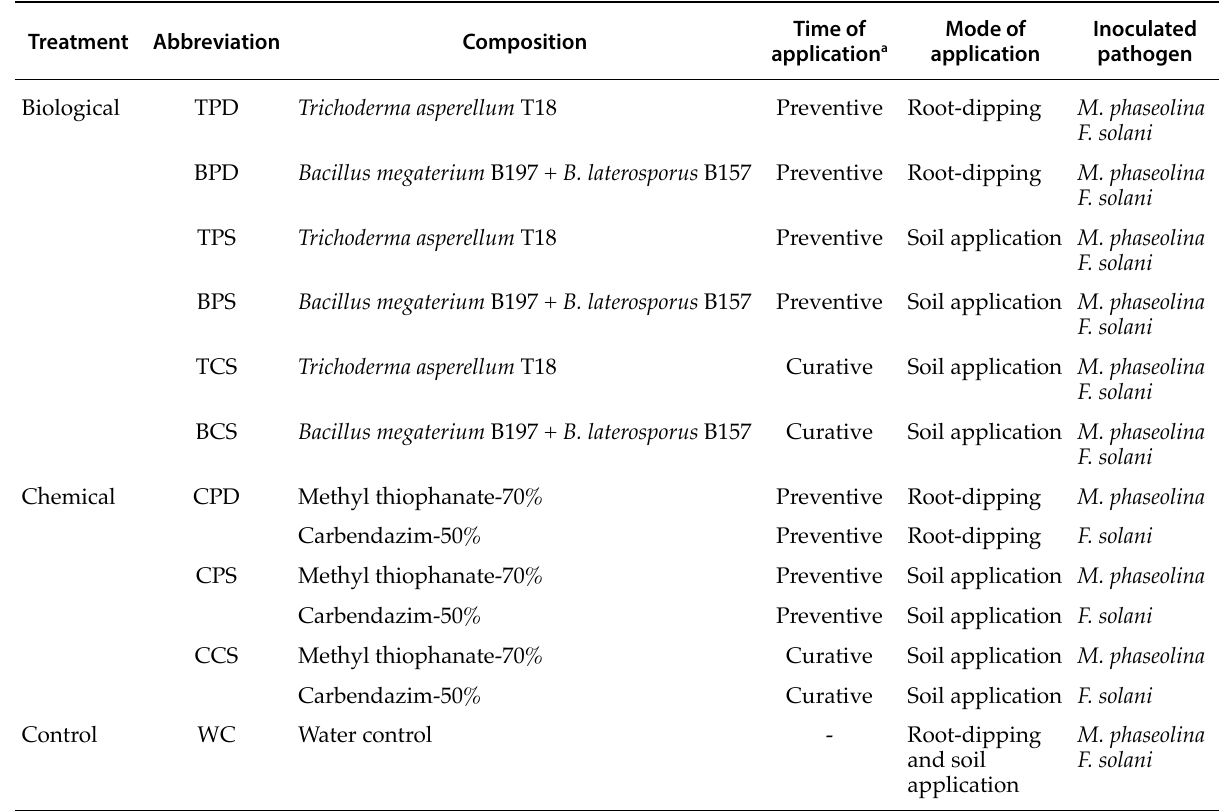
Table 1. Biological and chemical treatments assessed for control of charcoal rot (caused by Macrophomina phaseolina ) and crown and root rot (caused by Fusarium solani ) in